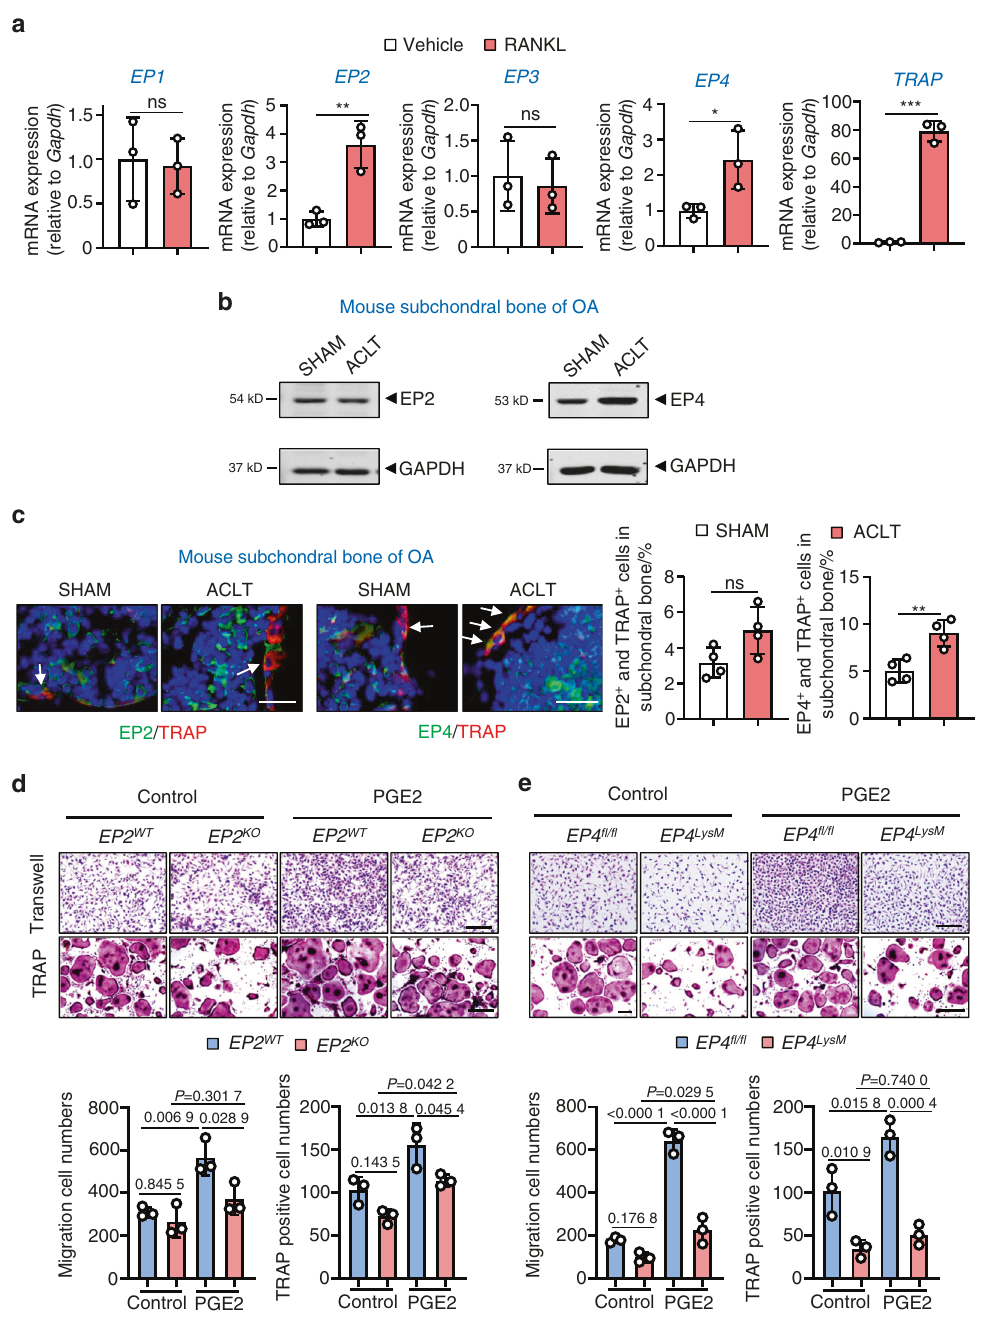
Fig. 1 Expression of EP2 and EP4 in subchondral bone osteoclasts and the effects of PGE2 on osteoclasts with EP2 and EP4 deletion. a qRT- PCR analysis of the mRNA expression levels of EP1 , EP2 , EP3 , EP4 , and Trap in osteoclasts differentiated from BMMs exposed to 10 ng·mL − 1 M-CSF and 50 ng·mL − 1 RANKL for 5 – 6 days. Error bars are the mean ± s.d. n = 3. * P < 0.05, ** P < 0.01 and *** P < 0.001, ns, not signi fi cant by unpaired two-tailed Student ’ s t test. b Representative images of the protein levels of EP2 and EP4 in mouse tibial subchondral bone tissue 2 weeks after sham or ACLT surgery. The experiments were performed with three biological replicates. c Representative images of IHF staining of EP2 or EP4 (green) and TRAP (red) in subchondral bone 2 weeks post-sham or ACLT surgery (left) and quantitative analysis (right). The white arrows indicate TRAP-positive osteoclasts expressing EP2 or EP4. Error bars are the mean ± s.d. * P < 0.05, ns, not signi fi cant by unpaired two- tailed Student ’ s t test. n = 4 for per group. Scale bars, 20 μ m. d EP2 deletion inhibits PGE2-induced migration and osteoclast differentiation. BMMs from the EP2 WT and littermate EP2 KO mice were used to generate osteoclasts by stimulation with 10 ng·mL − 1 M-CSF and 50 ng·mL − 1 RANKL and incubation with 100 nmol·L − 1 PGE2. Representative image of cells from the Transwell migration assay (Transwell) and osteoclast differentiation assay (TRAP staining) (top) and the corresponding quantitative analysis (bottom). Error bars are the mean ± s.d. n = 3. Two-way ANOVA followed by Tukey ’ s t tests. Scale bars, 50 μ m. e EP2 deletion inhibits PGE2-induced migration and osteoclast differentiation. BMMs from the WT ( EP4 fl / fl ) and littermate EP4 fl / fl : LysM-cre ( EP4 LysM ) mice were used to generate osteoclasts by stimulation with 10 ng·mL − 1 M-CSF and 50 ng·mL − 1 RANKL (5 – 6 days) and incubation with 100 nmol·L − 1 PGE2. Representative image of cells from the Transwell migration assay (Transwell) and osteoclast differentiation assay (TRAP staining) (top) and the corresponding quantitative analysis (bottom). Error bars are the mean ± s.d. n = 3. Two-way ANOVA followed by Tukey ’ s t tests. Scale bars, 50 μ